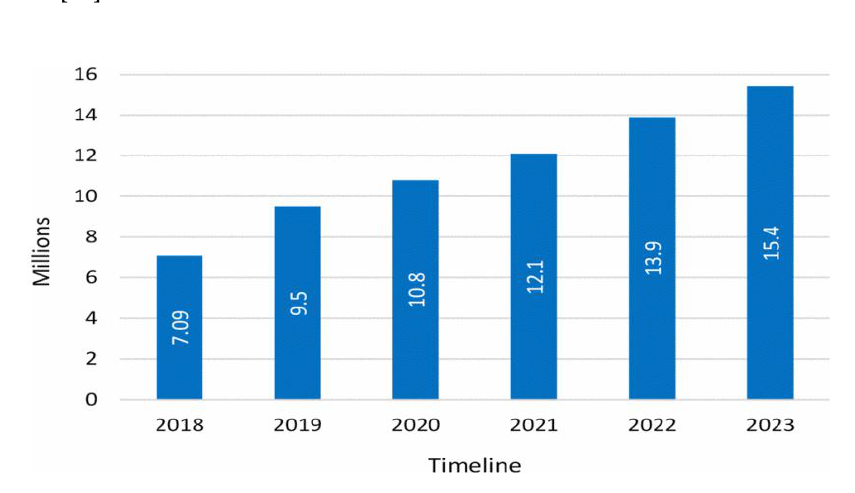
Figure 1. Yearly comparison of DDoS attacks in 2018–2023